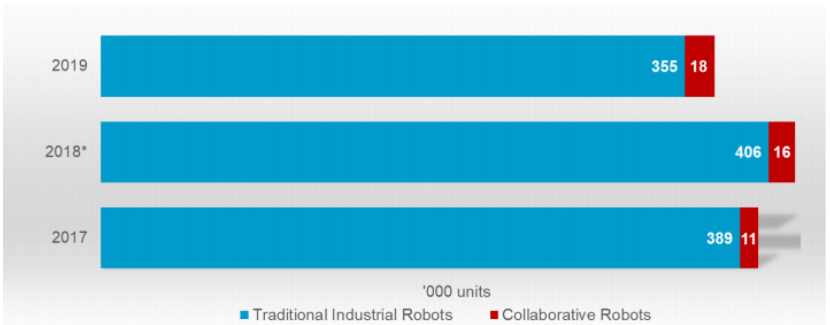
Figure 2. Annual evolution of the acquisition (×1000) of collaborative robots versus traditional robots [3].